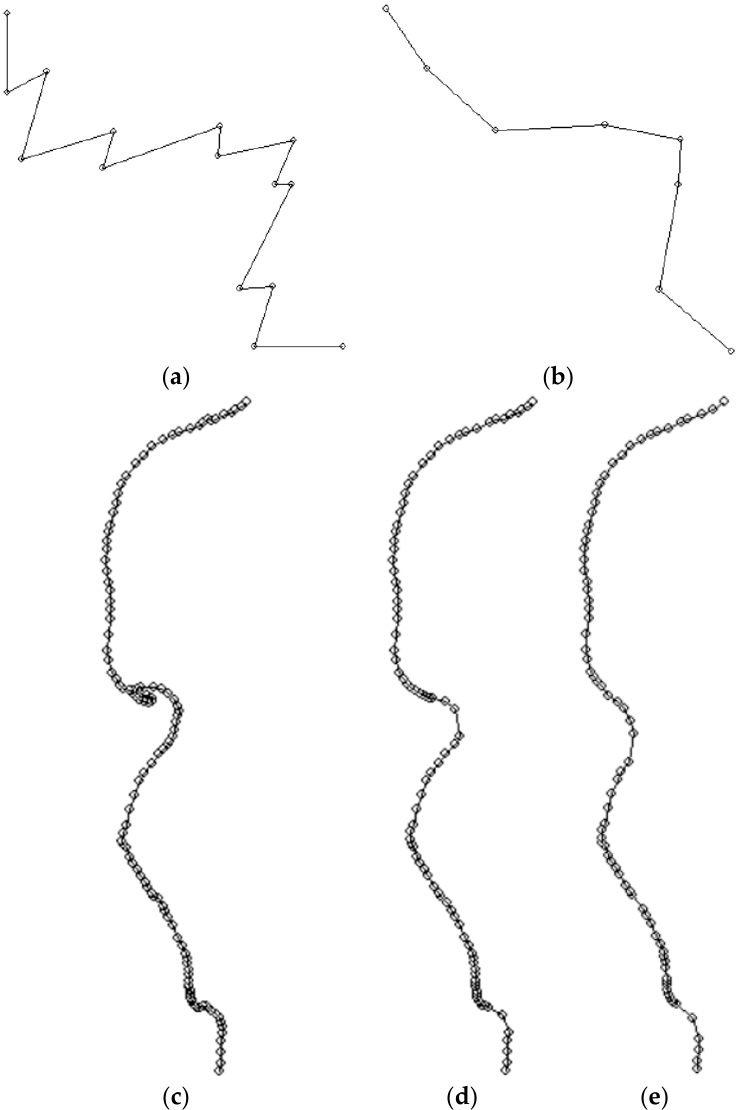
Figure 6. ( a ) Line string before generalization, initial number of vertexes—15, minimal radius—61 m; ( b ) Line string after generalization, final form, number of vertexes—8, radius of generalization (modal value × 1.6)—170 m; ( c ) Line string before generalization, initial number of vertices—125, scale of the map 1:25,000; ( d ) Line string after generalization, final form, number of vertices—94, radius of generalization (modal value × Map Scale Change Factor ( MSCF ))—65 m × 1.6 = 104 m, scale of the map 1:50,000; ( e ) Line string after generalization, final form, number of vertices—80, radius of generalization (modal value × MSCF )—105 m × 1.6 = 168 m, scale of the map 1:100,000.